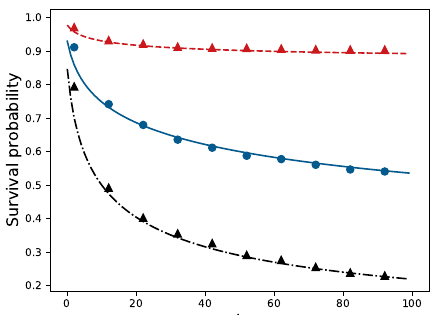
= − 2 (red dashed line), and v = 1 0